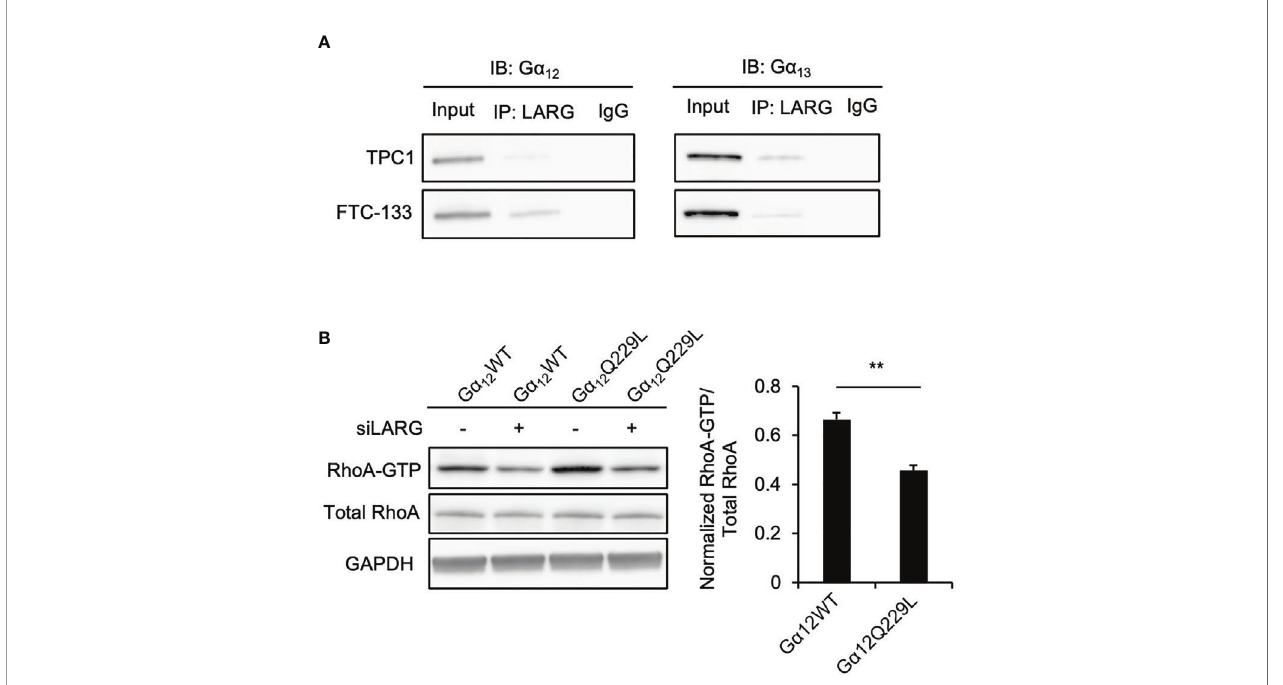
FIGURE 3 | G a 12/13 interacts with LARG to activate RhoA in thyroid cancer cells. (A) Co-immunoprecipitation (IP) of G a 12/13 -LARG using lysates prepared from thyroid cancer cells. Input, 20 µg of total proteins from each cell line. The exposure time was 2 minutes. Left panel, G a 12 immunoblots from lysates immunoprecipitated with anti-LARG or control IgG in TPC1 and FTC-133 cells. Right panel, G a 13 immunoblots from lysates immunoprecipitated with anti-LARG or control IgG in TPC1 and FTC-133 cells. Data are representative of 3 sets of independent experiments. (B) Immunoblots of RhoA, and GAPDH from total cell lysates and RhoA after GST-Rhotekin pull-down (RhoA-GTP form) in TPC1 stably transfected with G a 12 WT or G a 12 Q229L then transiently transfected with siNT or siLARG. The bar graph represents relative active RhoA levels in TPC1 cells stably transfected with G a 12 WT or G a 12 Q229L and then transiently transfected with siLARG normalized to control. Data represent means ± SEM of 3 independent experiments. ** P <